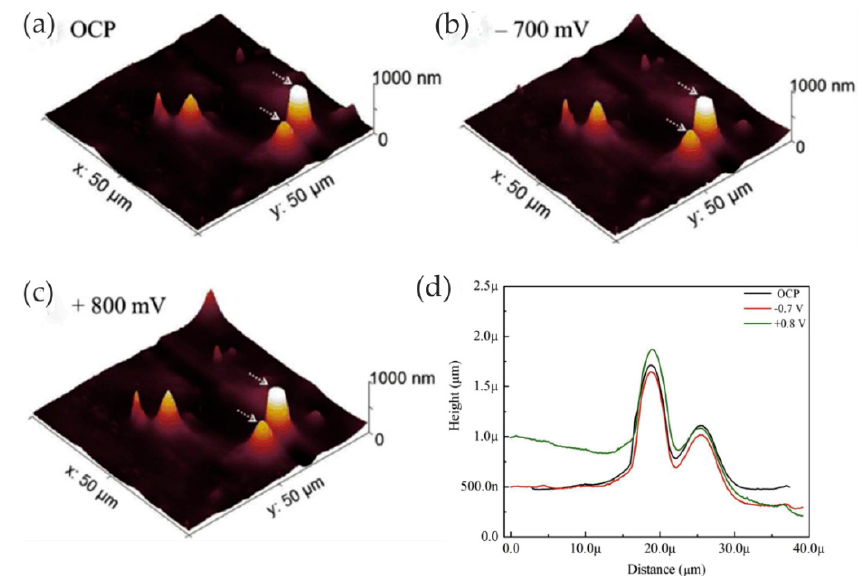
Figure 29. EC-AFM images (3D) of the same scan area of the composite coating in 3.0 wt% NaCl solution obtained after 60 min ( a ) at OCP, ( b ) at − 700 mV (vs. Ag/AgCl), and ( c ) at 800 mV (vs. Ag/AgCl). ( d ) Line profiles of CeO 2 nanoparticle (CeNP) aggregates when at the two applied potentials drawn by the crossing line. Reprinted with permission from Reference [66]; copyright 2019 Elsevier Ltd.